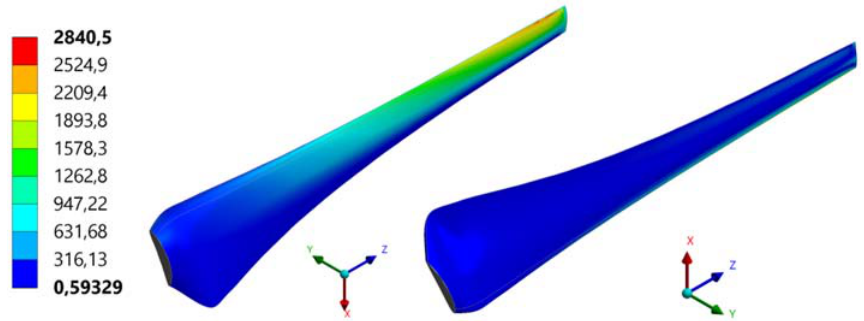
Figure 8. Map of imported pressure on the pressure and suction sides of the blade (results in [Pa]).